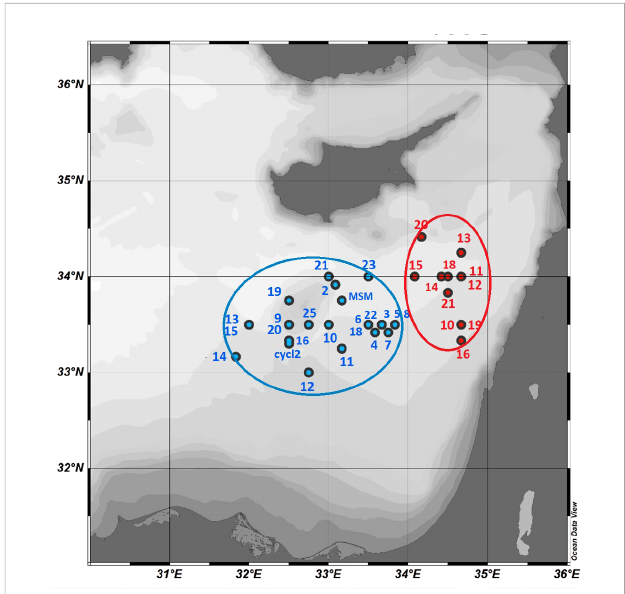
FIGURE 7 Seasonal and inter-annual migration of the Cyprus Eddy center (in blue) and of the Shikmona Eddy center (in red) from 1996 to 2012. Label next to each location indicates the cruise number listed in Table 1A.